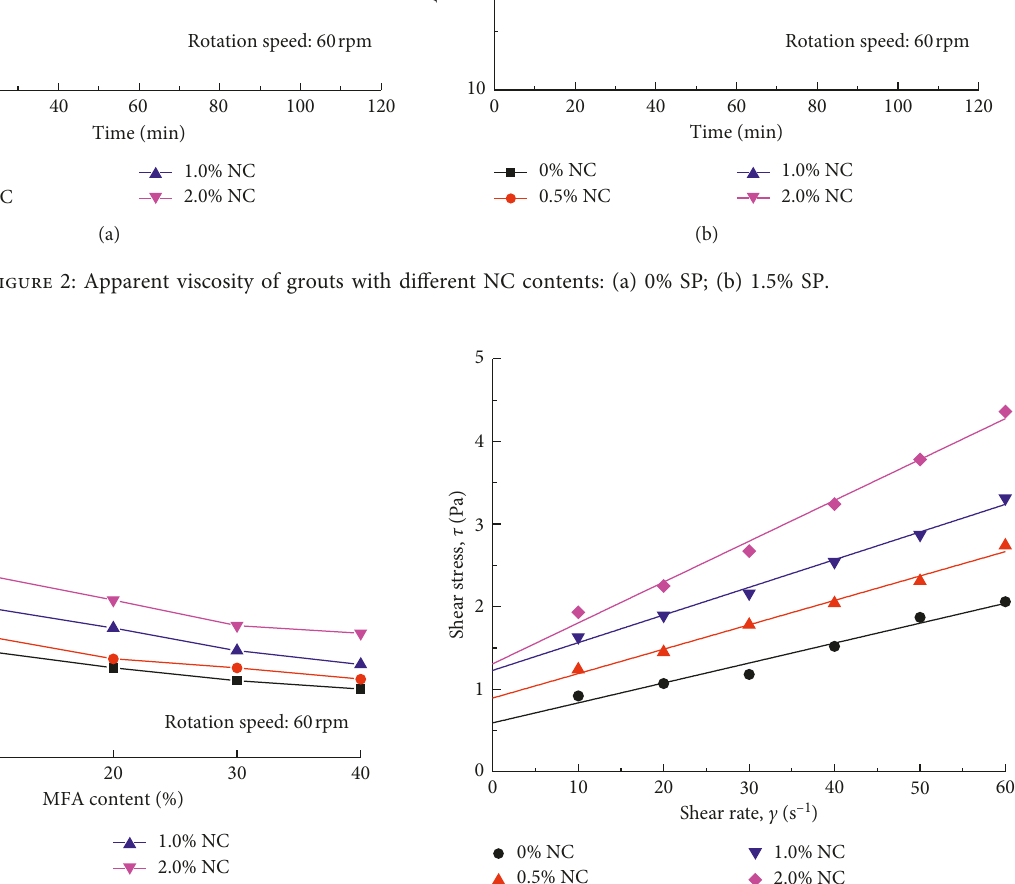
Figure 3: Variations in the initial apparent viscosity of fresh grouts with different MFA and NC contents.